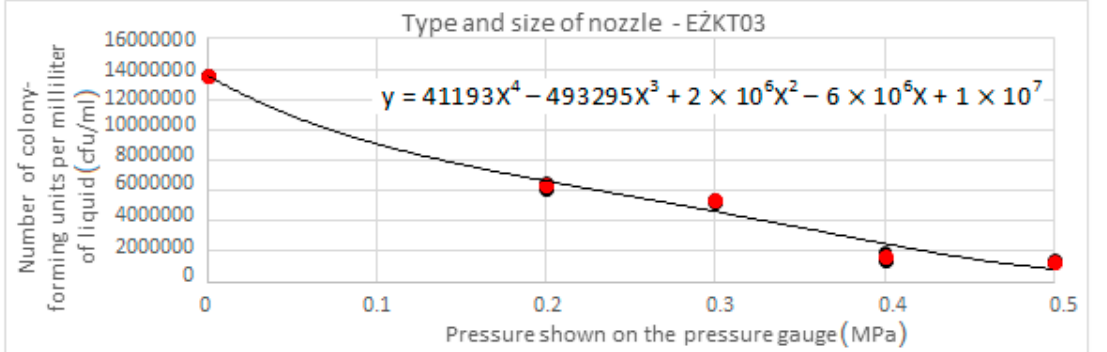
8 of 13 Figure 8. The influence of pressure on survival of cfu/mL of liquid for E Ż KT02. The vertical axis shows the cfu/mL values, while the horizontal axis shows the pressure (MPa) values set in the throttling valve and read in manometers.